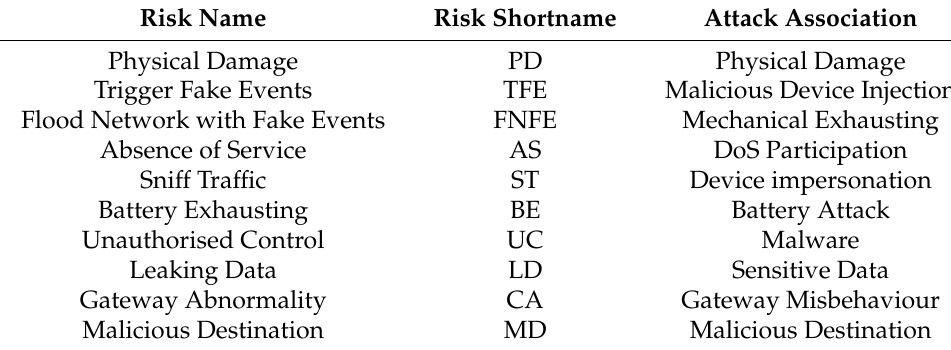
Table 1. Risks and attacks association.